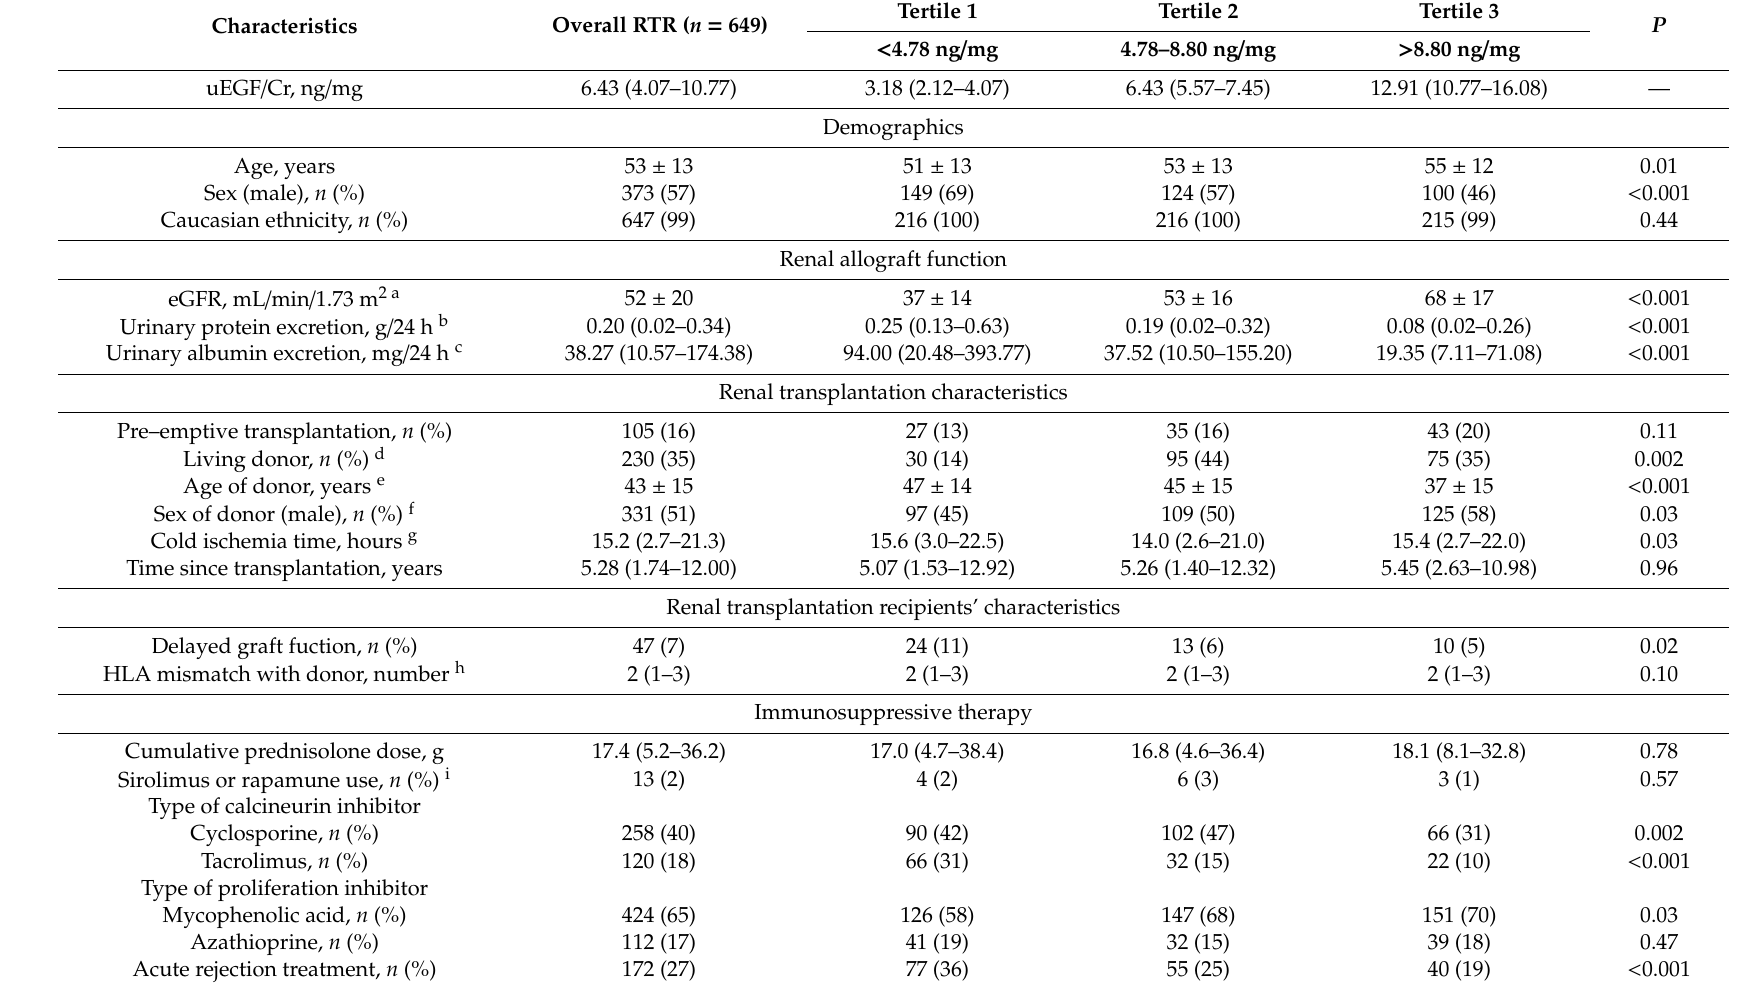
Table 1. Characteristics at enrollment of the study